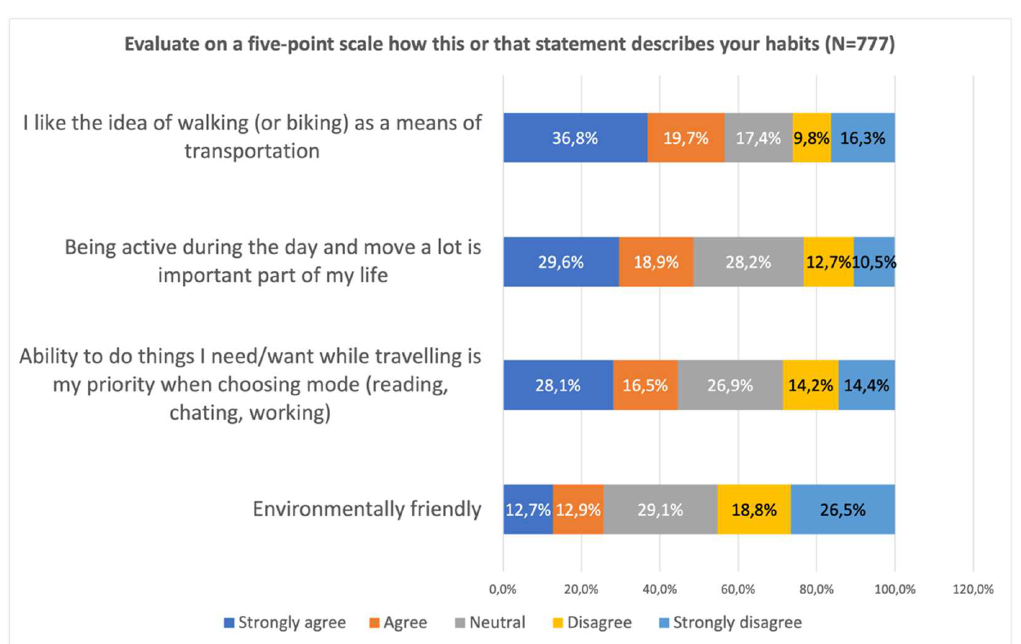
Figure 12. Attitudes of respondents (N = 777).